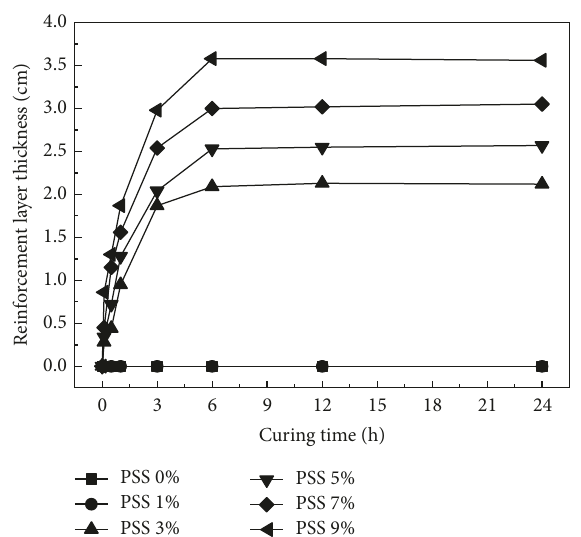
Figure 6: The reinforcement layer thickness of specimens with different curing times.